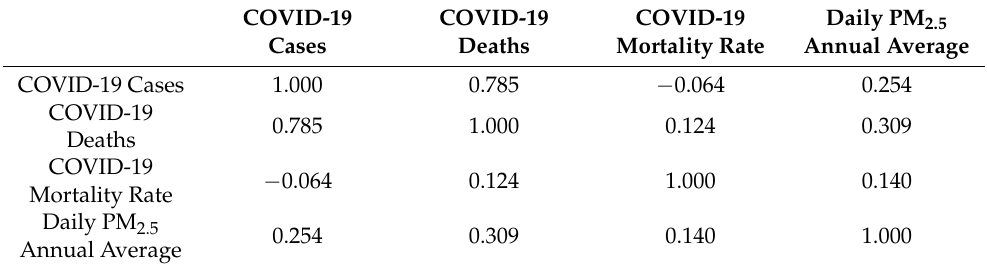
Table 1. Kendall’s tau correlation analysis.